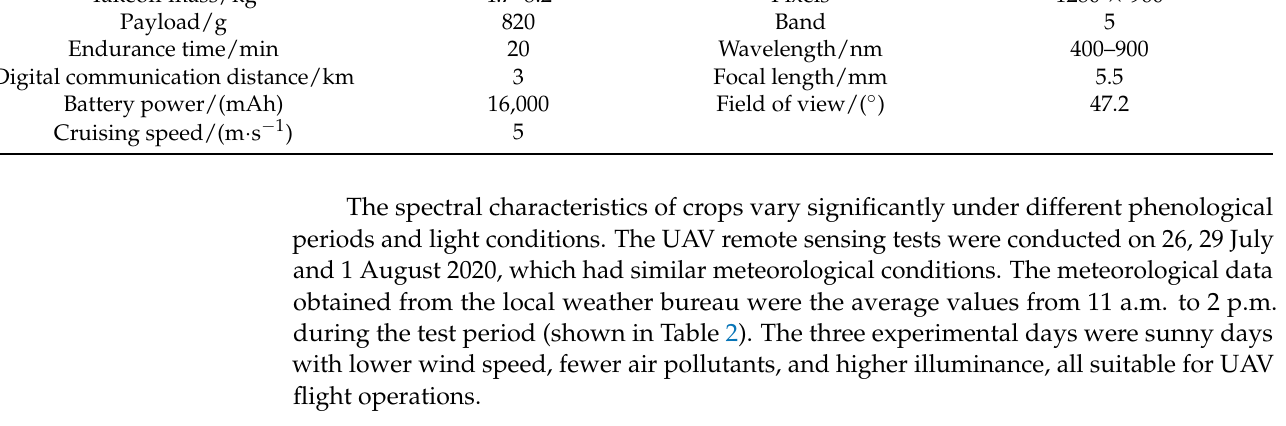
Table 2. Meteorological data of the study areas during the